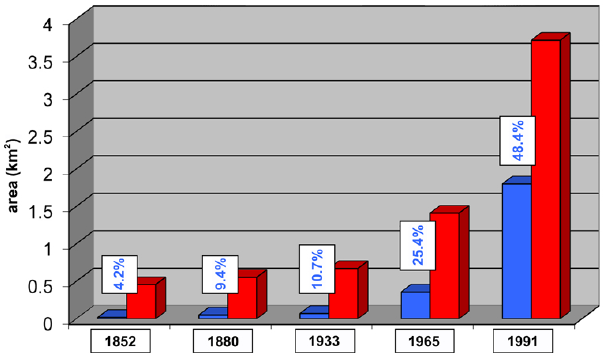
Fig. 12. Urban development of Alba measured from maps of 1852, 1880, 1933, 1965, 1991 (in red), compared with percentage of the urban area would have been flooded in those years by an event sim- ilar to that of November 1994 (in